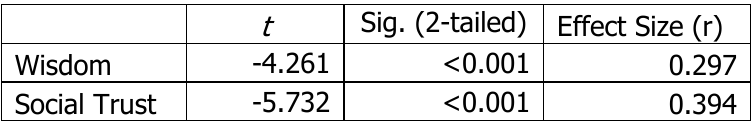
Paired t-Tests for Wisdom and Social Trust